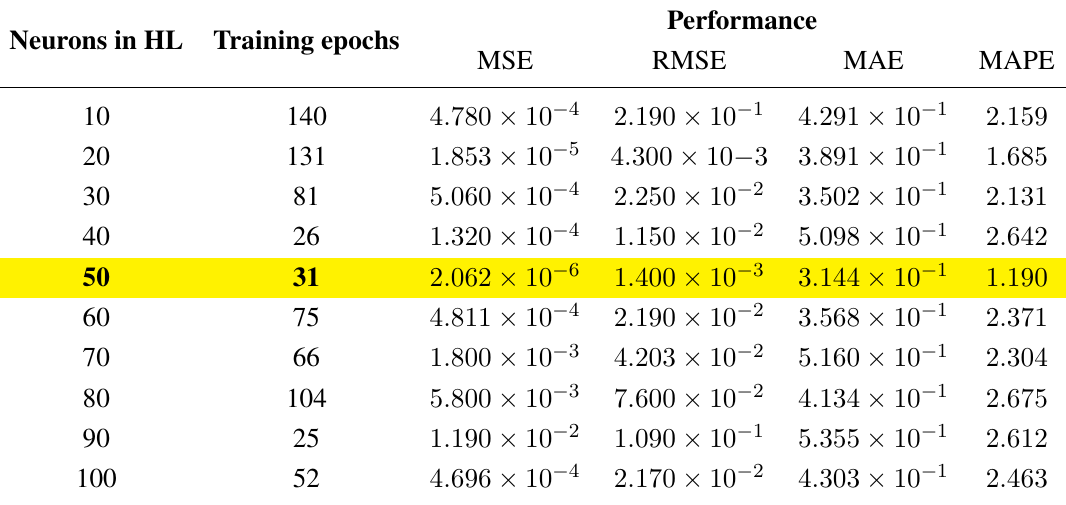
Table 3. Performance in the summer scenario. HL, hidden layer.